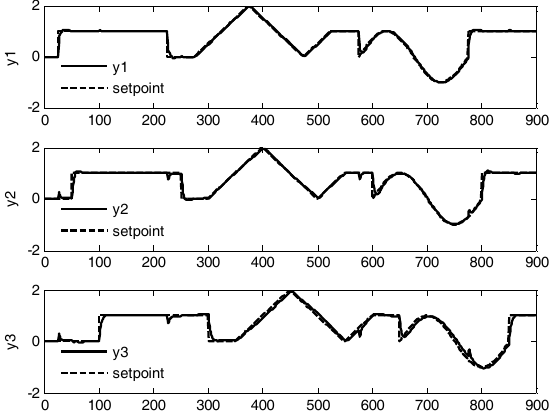
Figure 8. Control results of conventional MPC in dynamic PLS.